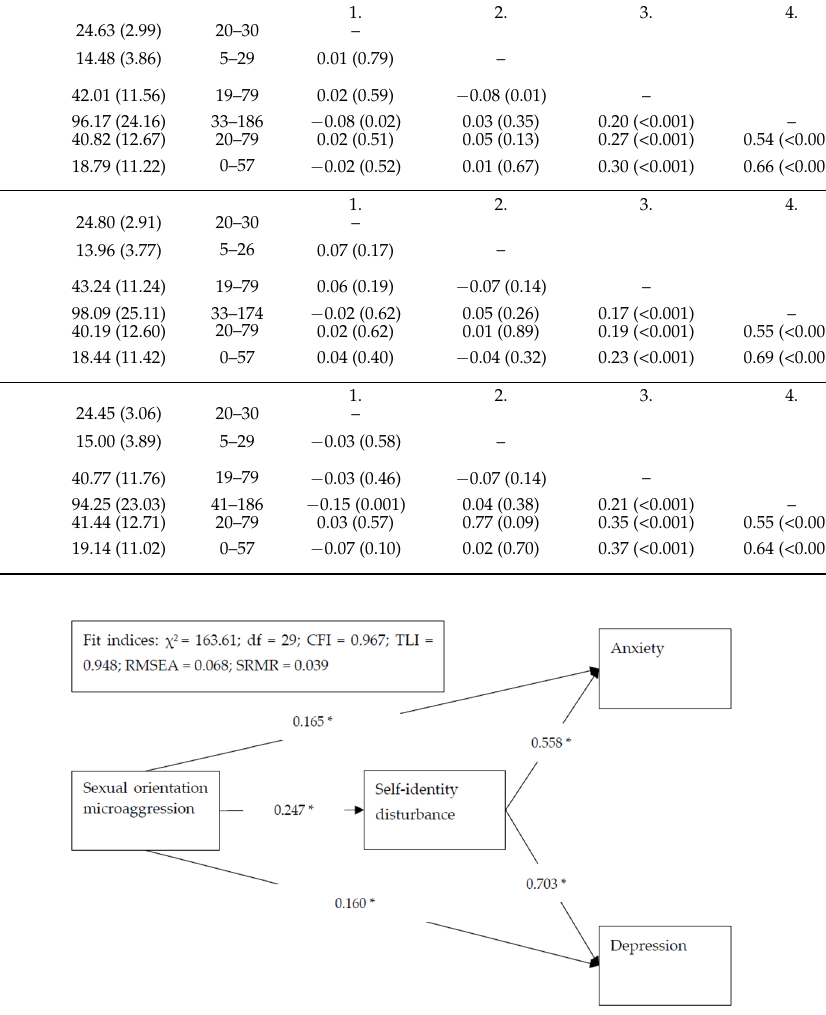
Figure 1. Structural equation model results with standardized regression coefficients for the proposed model. Age was controlled in the model. * p < 0.001.